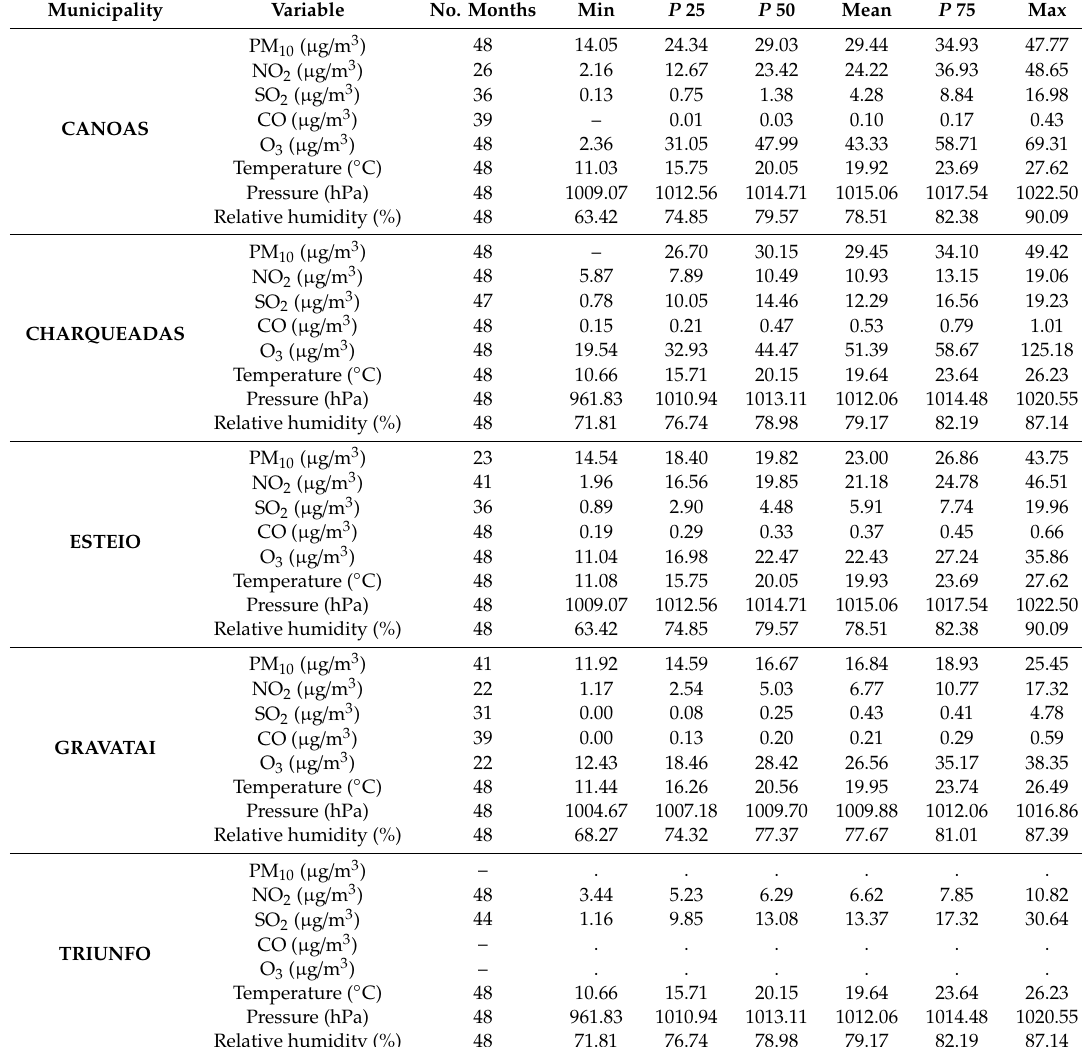
Table 3. Monthly average concentrations of atmospheric pollutants and meteorological parameters by municipality, Rio Grande do Sul State, Brazil 2013–2016.